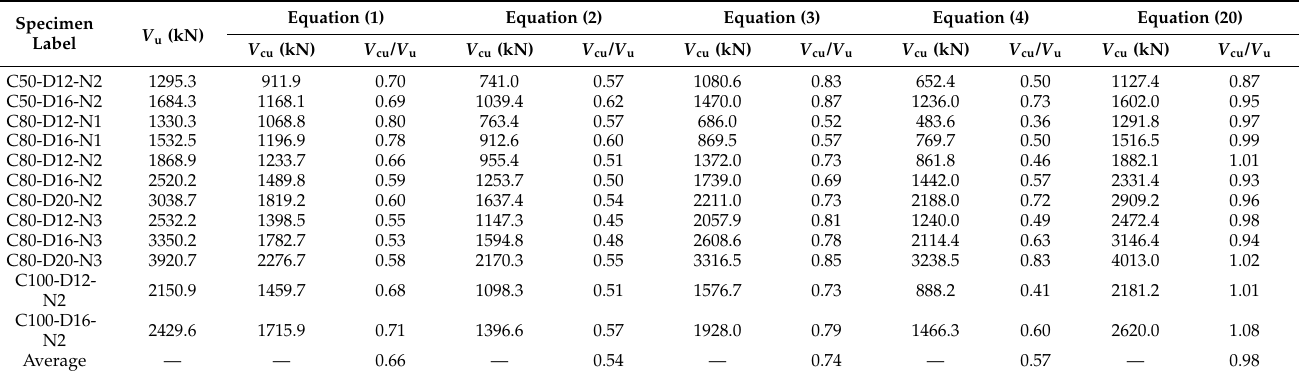
Table 4. Comparison between test and calculation